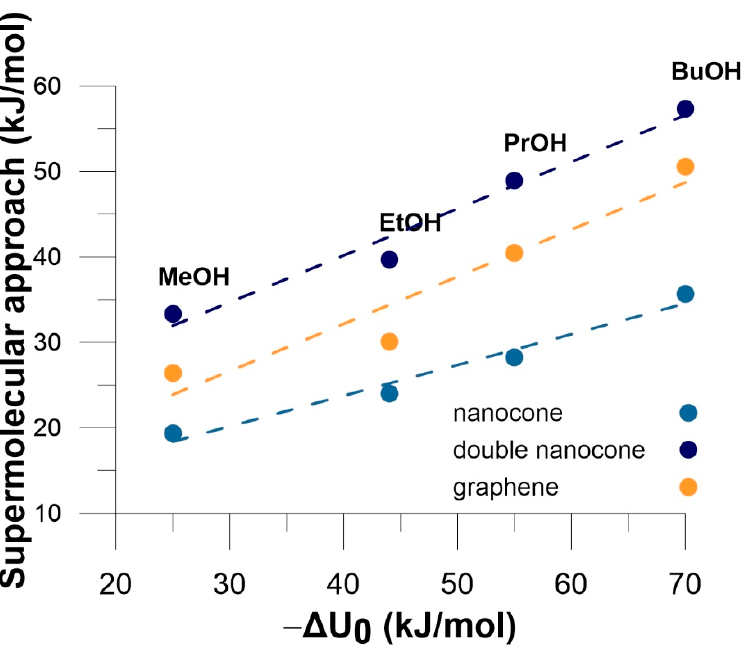
Figure 7. The relation between the energies calculated using DFT and the values of experimental enthalpy of adsorption at zero